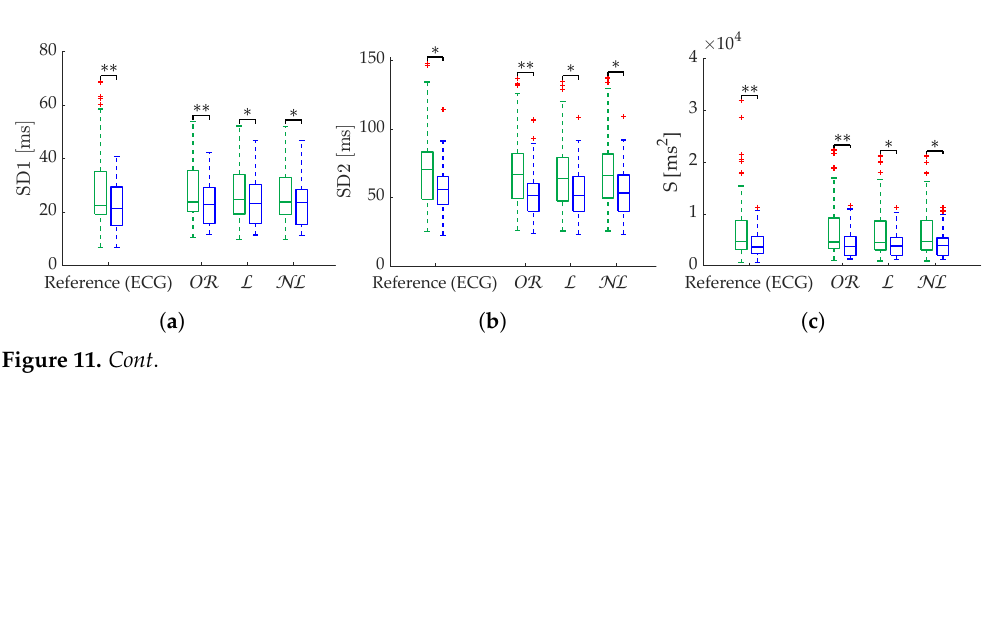
Figure 10. Coverage of Poincaré metrics from Apple Watch dataset. ( a ) SD1. ( b ) SD2. ( c ) Md. ( d ) Sd.